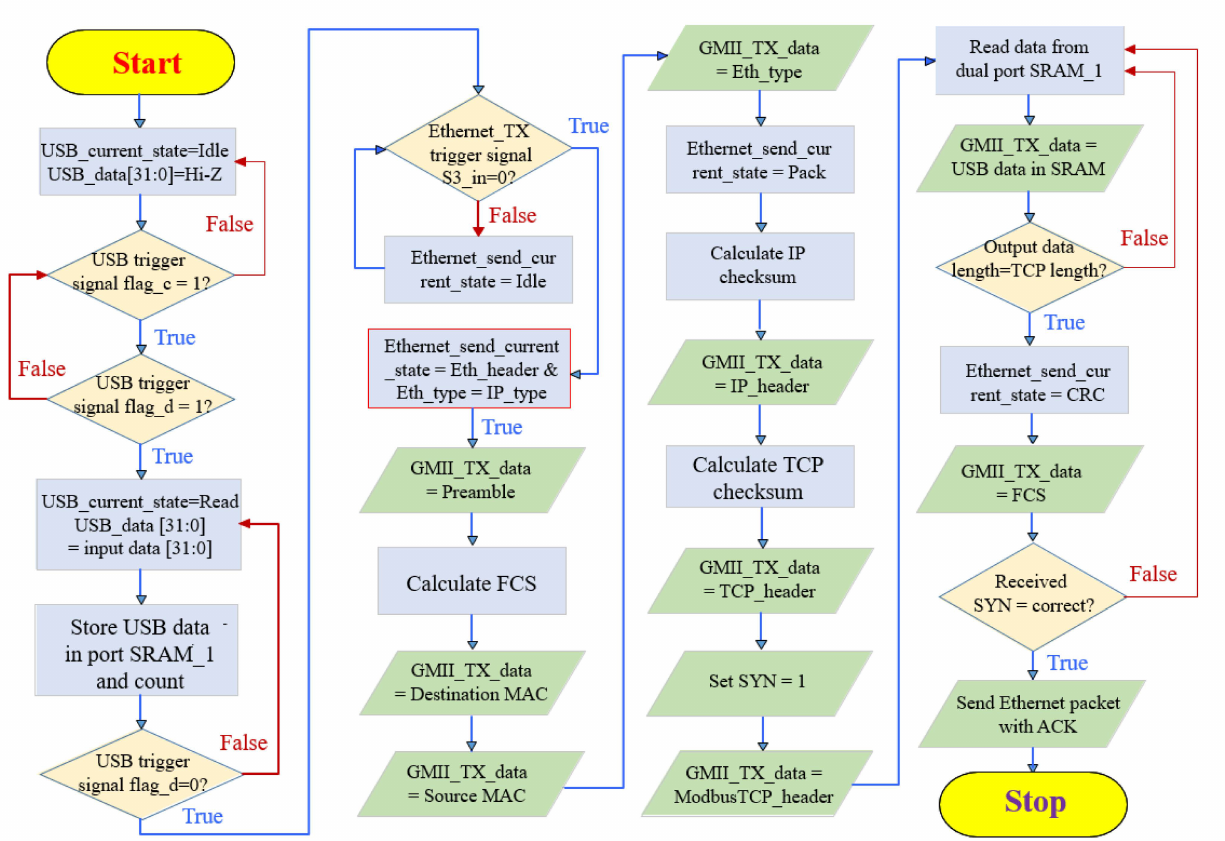
Figure 9. Flowchart of the USB data to Ethernet packet receiving and conversion